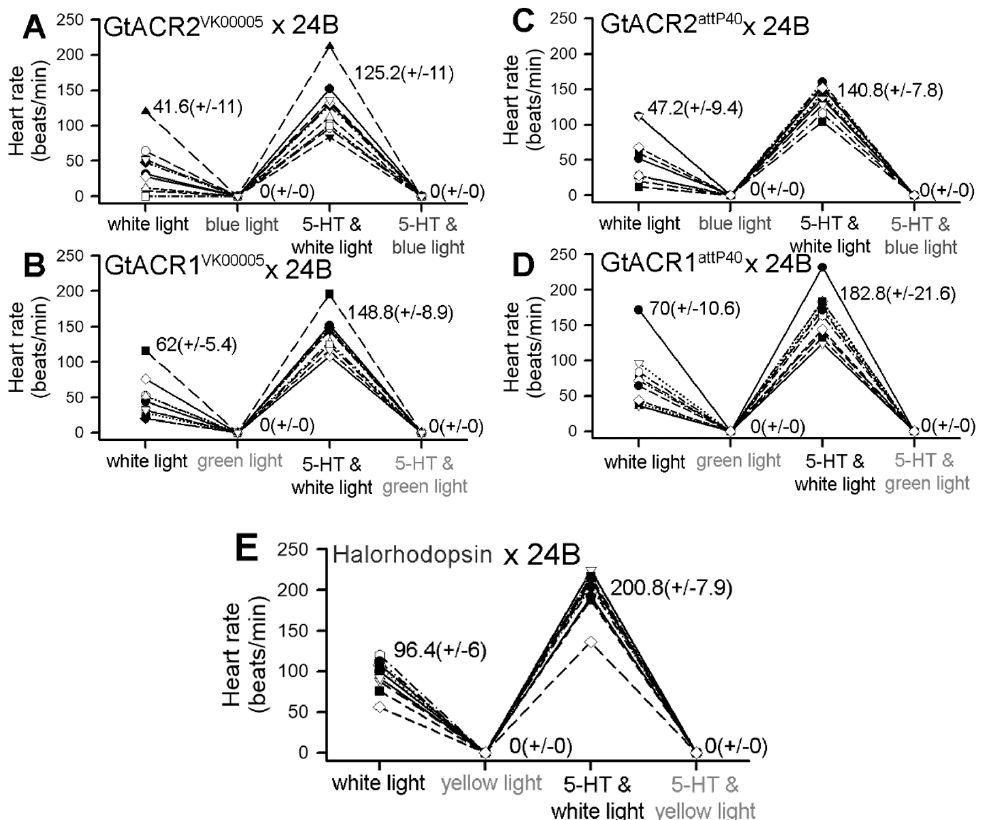
Figure 3. Heart rate of dissected larvae before and during exposure to the appropriate wavelength of light and the effects of serotonin (5-HT). Heart rates for all larvae in the GtACR2 VK00005 × 24B line ( A ), the GtACR1 VK00005 × 24B line ( B ), the GtACR2 ATTP40 × 24B line ( C ), the GtACR1 ATTP40 × 24B line ( D ), and the Halorhodopsin (eNpHR) × 24B line ( E ) decreased to zero after direct exposure to the light, increased after exposure to 5-HT, and decreased back to zero after direct exposure to the light in the presence of 5-HT. Green (166.5 W/m 2 ), blue (101.3 W/m 2 ) or yellow (623.7 W/m 2 ) light was used. Mean (±SEM) values are presented next to each distribution. Each group is significantly different from the other groups except between the distributions in which a light is used without and with 5-HT. ( p < 0.05, Friedman repeated measures ANOVA and a post hoc Bonferroni t-test). The larval hearts of the eNpHR line all stopped beating with 567.5 nm yellow light exposure in saline without and with 5-HT (1 µM) (Figure 3E, n = 10; p < 0.05, Sign test). A video supplement (Supplement S4-video) illustrates a representative heart tube ceasing to beat with yellow light exposure in a dissected eNpHR -expressing larva. All the preparations also exhibited an increased heart rate with exposure to 5-HT.